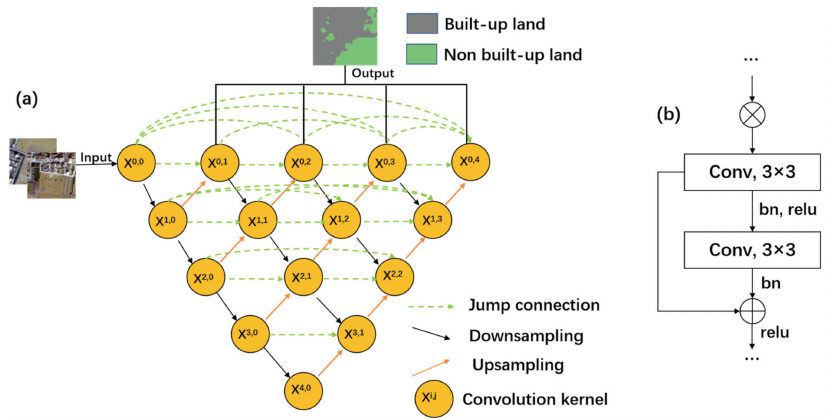
Figure 6. The overall flowchart of the proposed Res-UNet++ model. ( a ) the main flowchart of Res- UNet++; ( b ) the flowchart of Resnet18 residual basic-block (bn-batch normalization layer, relu-the activation function, Conv-convolution layer.).